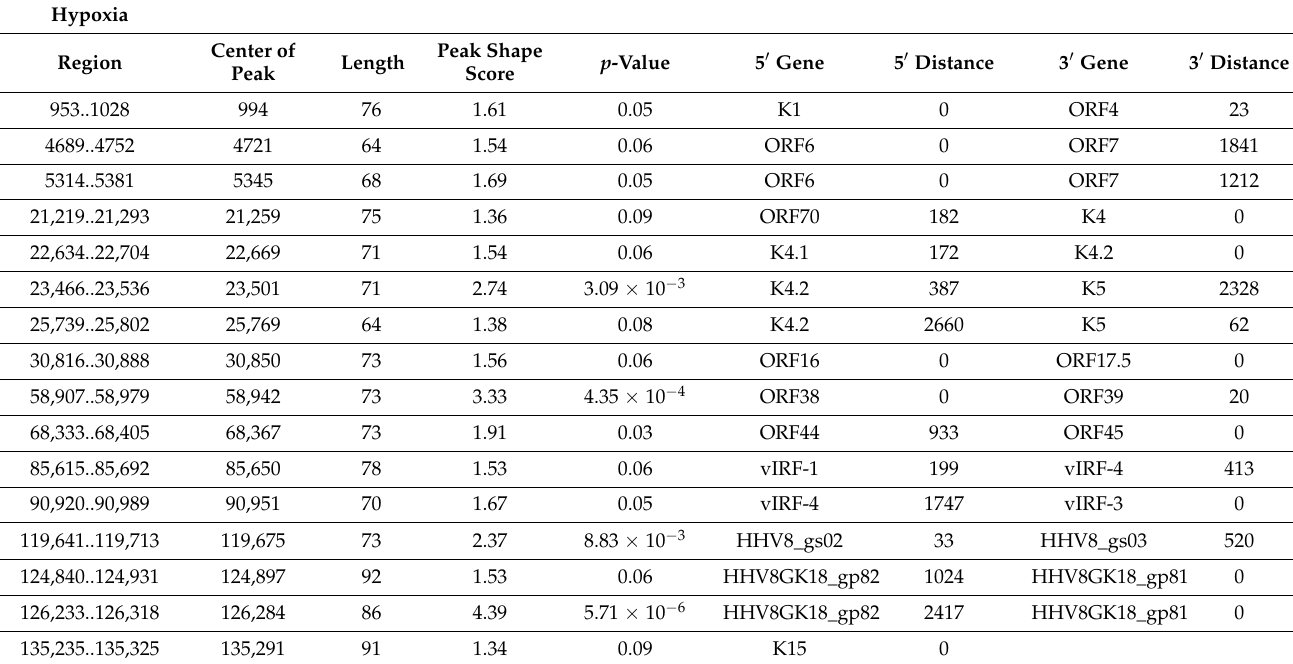
Table 1. Enrichment of DNA Polymerase 1 α on KSHV genome in hypoxia. DNA Pol 1A Hypoxia